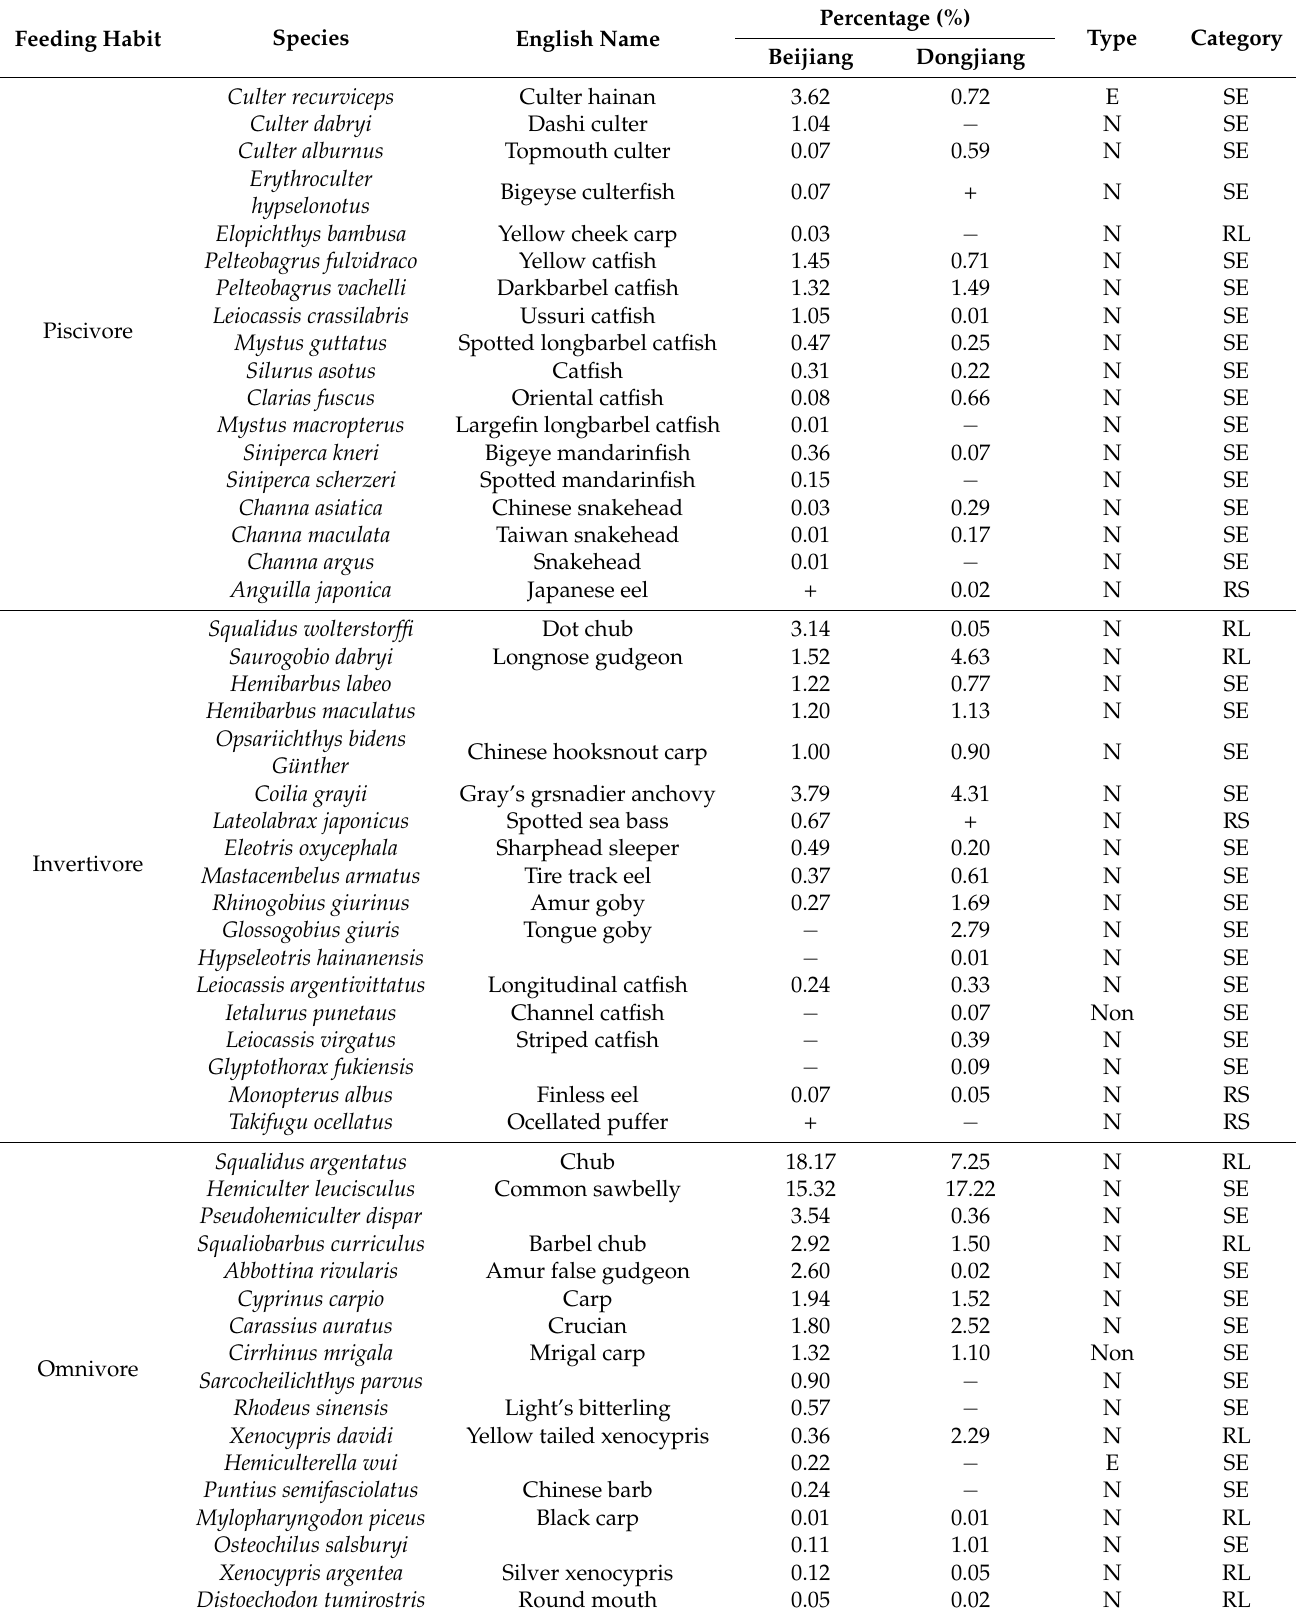
Table 2. Fish community structure in the Dongjiang River and Beijiang River. Feeding